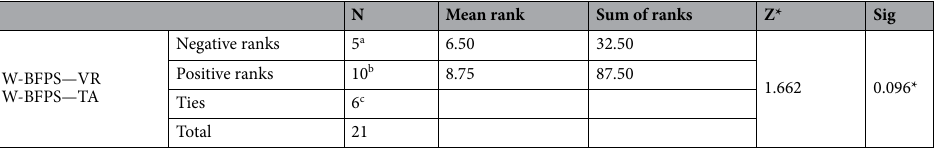
Table 1. Comparisons and ranking of W-BFPS. *Calculated using the Wilcoxon Sign Rank test. Differences are not statistically significant. a W-BFPS—TA < W-BFPS—VR. b W-BFPS—TA > W-BFPS—VR. c W-BFPS— TA =